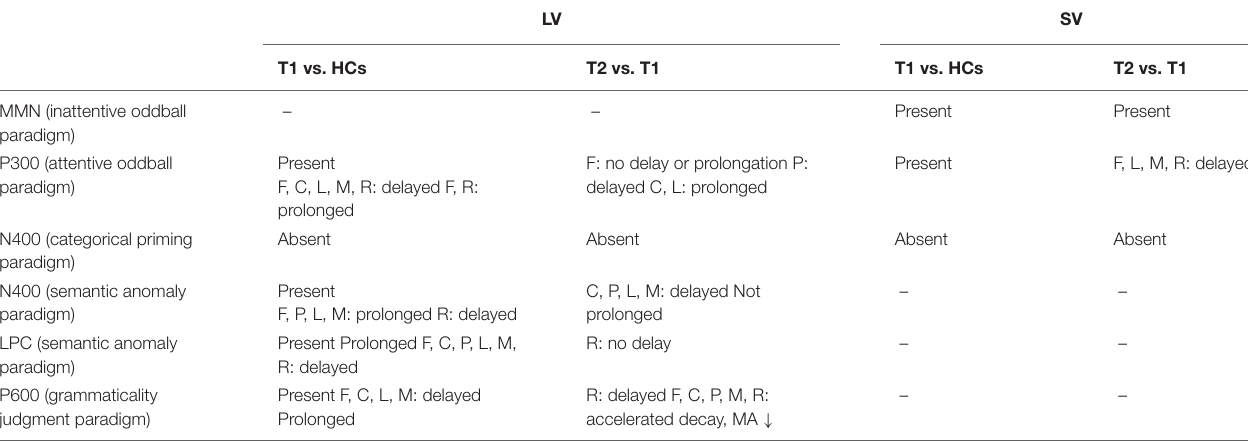
TABLE 4 | The electrophysiological results of each ERP component in the patients with LV and SV who did not receive SLT at the initial assessment and the follow-up assessment.